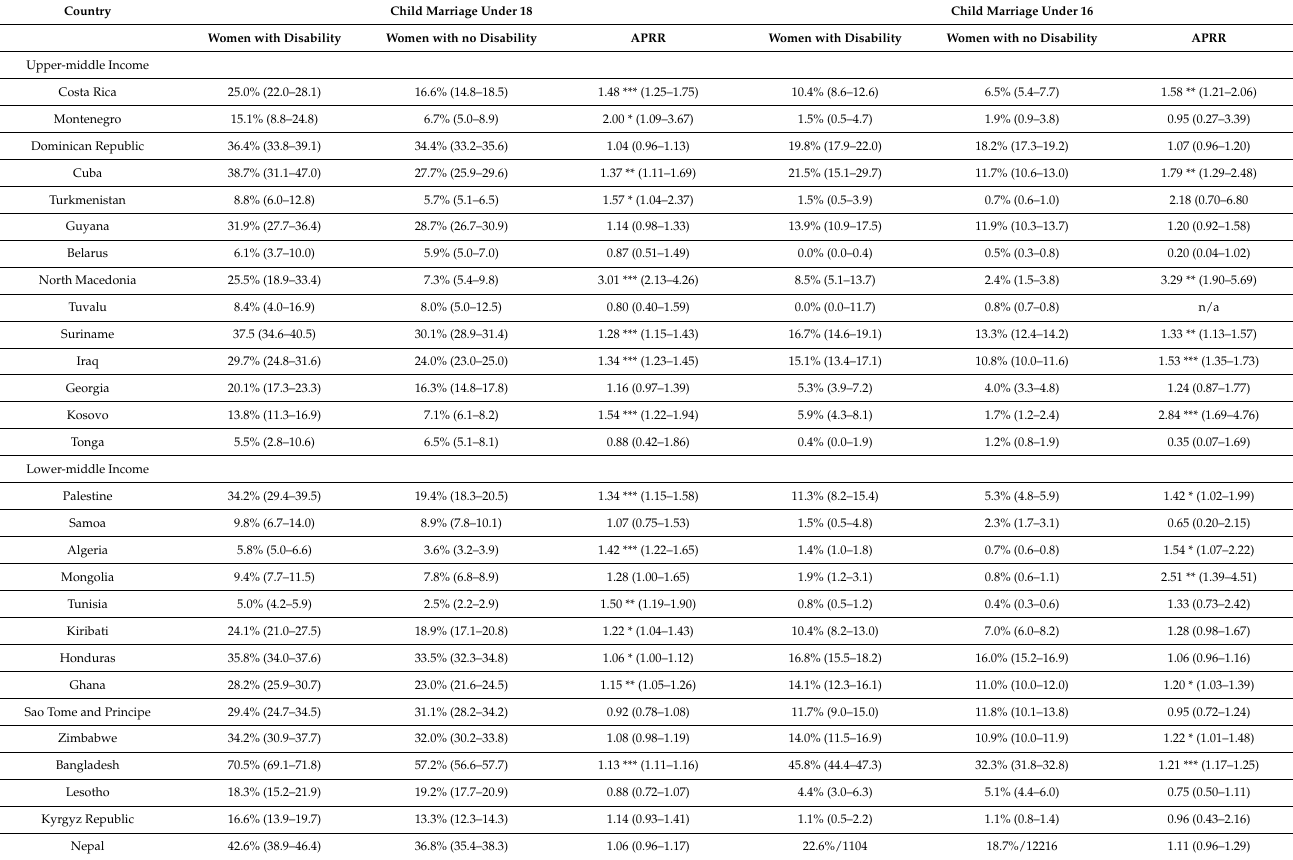
Table 3. Prevalence and Risk of Child Marriage by Disability